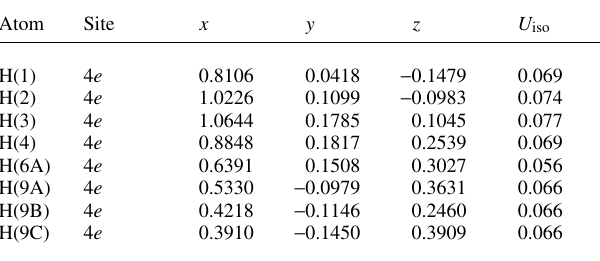
Table 2. Atomic coordinates and displacement parameters (in Å 2 )